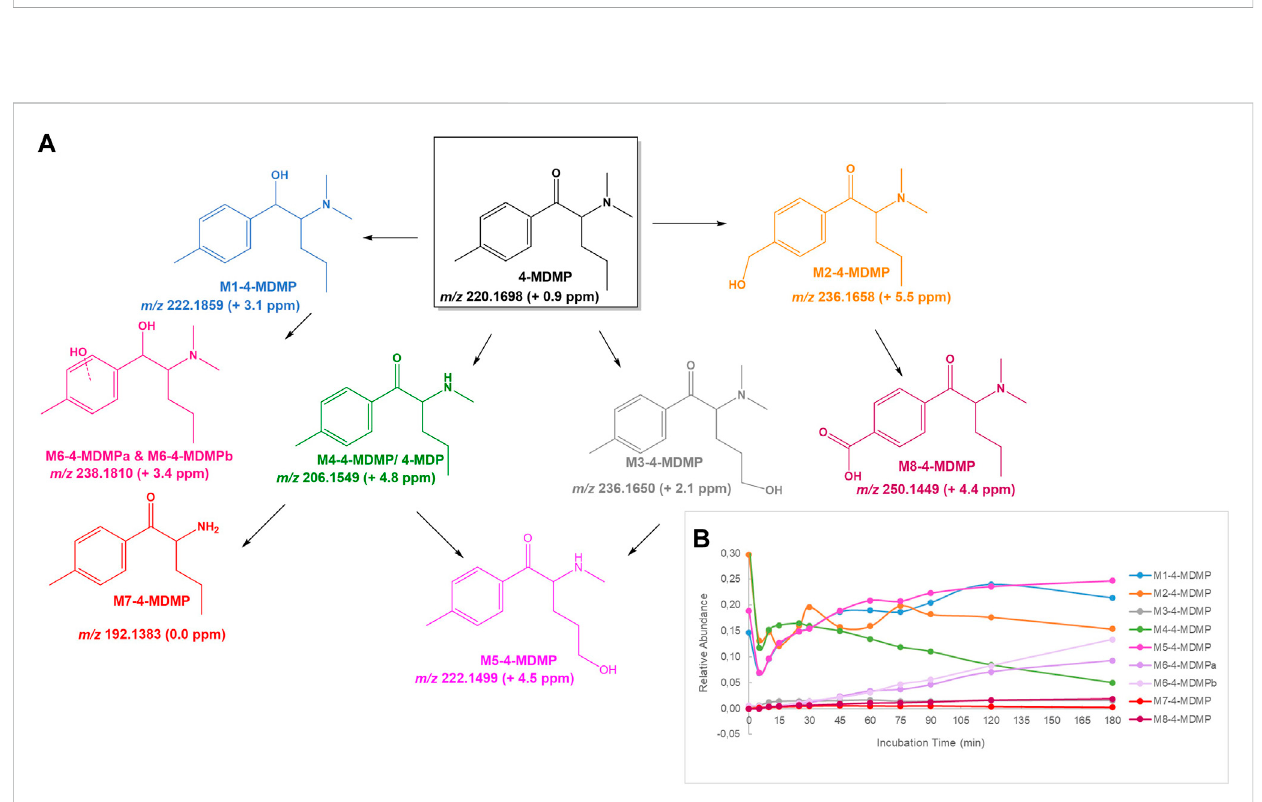
hydroxylation. M4-4-MDMB is observed at m/z 224.1655 (+4.5 ppm), and the base peak of its tandem mass spectrum stems from water loss at m/z 206.1550 (+5.1 ppm). The location of the hydroxyl group at the ethyl chain is only suggested